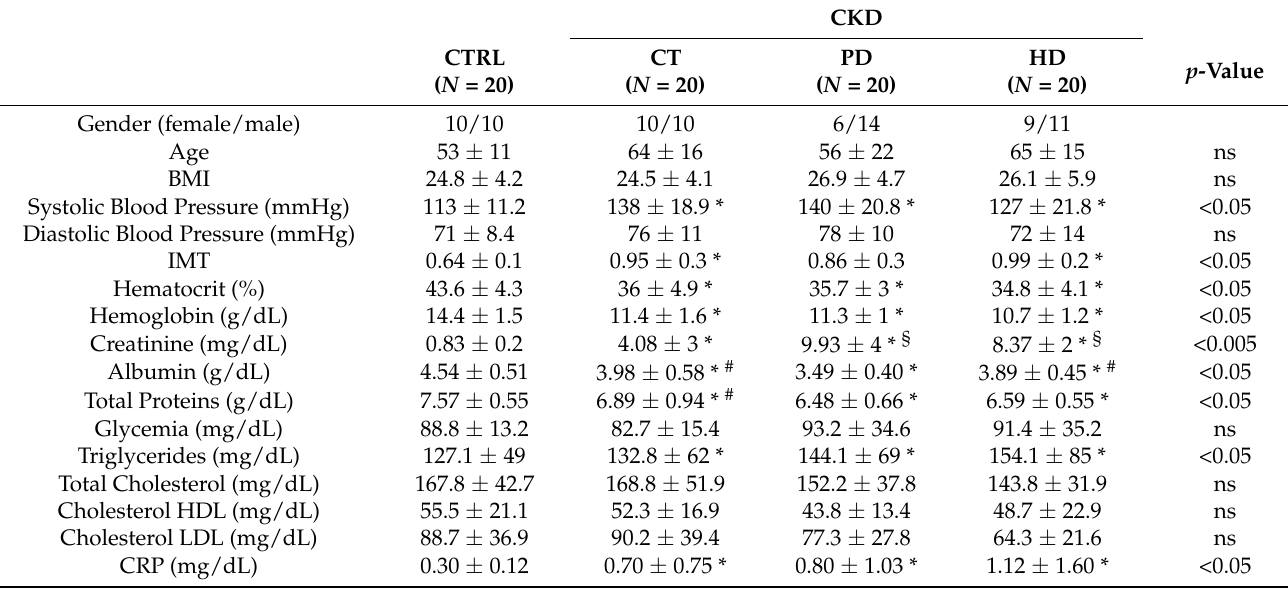
Table 1. Main clinical and biochemical characteristics of the study population.